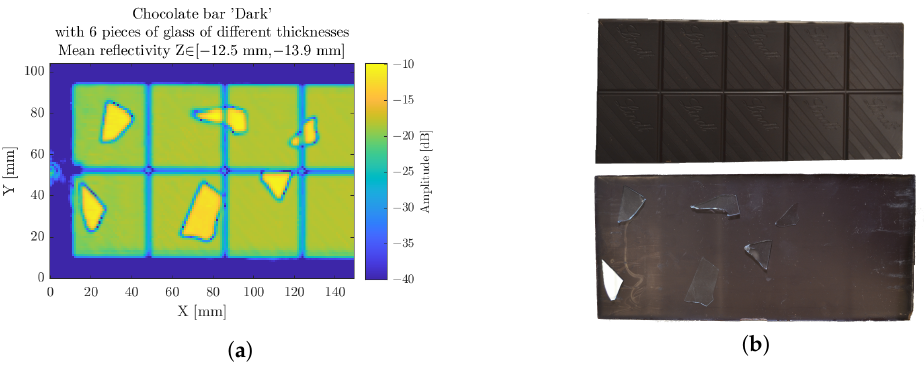
Figure 14. The chocolate bar scan, considered on a longitudinal range of interest on the backside ( a ). Photography of the front and back sides of the sample ( b